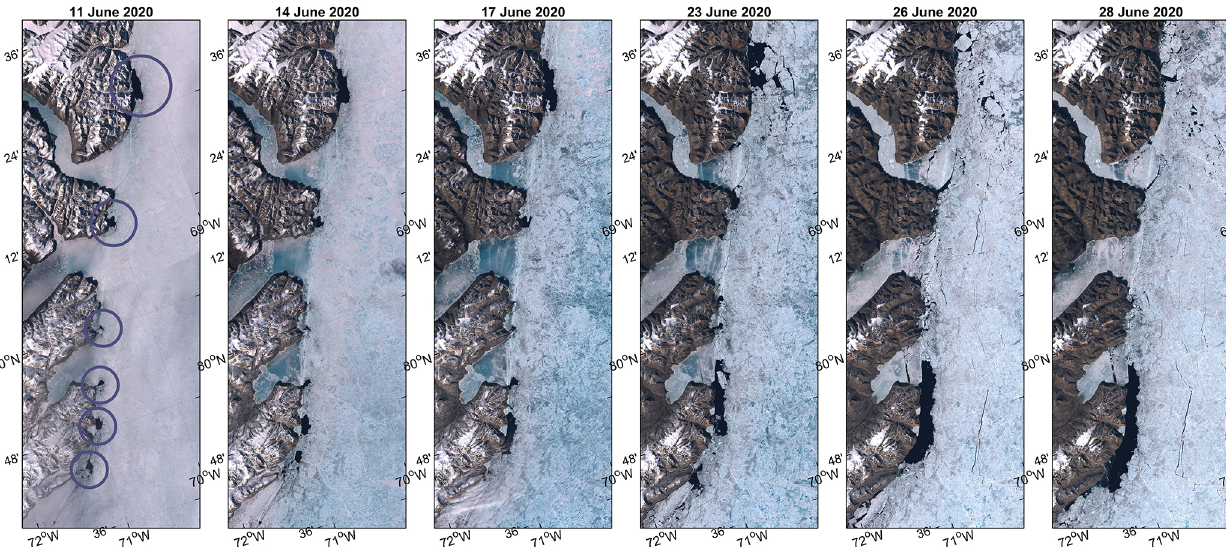
Figure 11. The series of Sentinel-2 images showing the evolution of polynyas along the western coast of Kane Basin from their first appearance until the start of bridge collapse in June 2020. The circles in the leftmost panel indicate the regions where open-water polynyas first